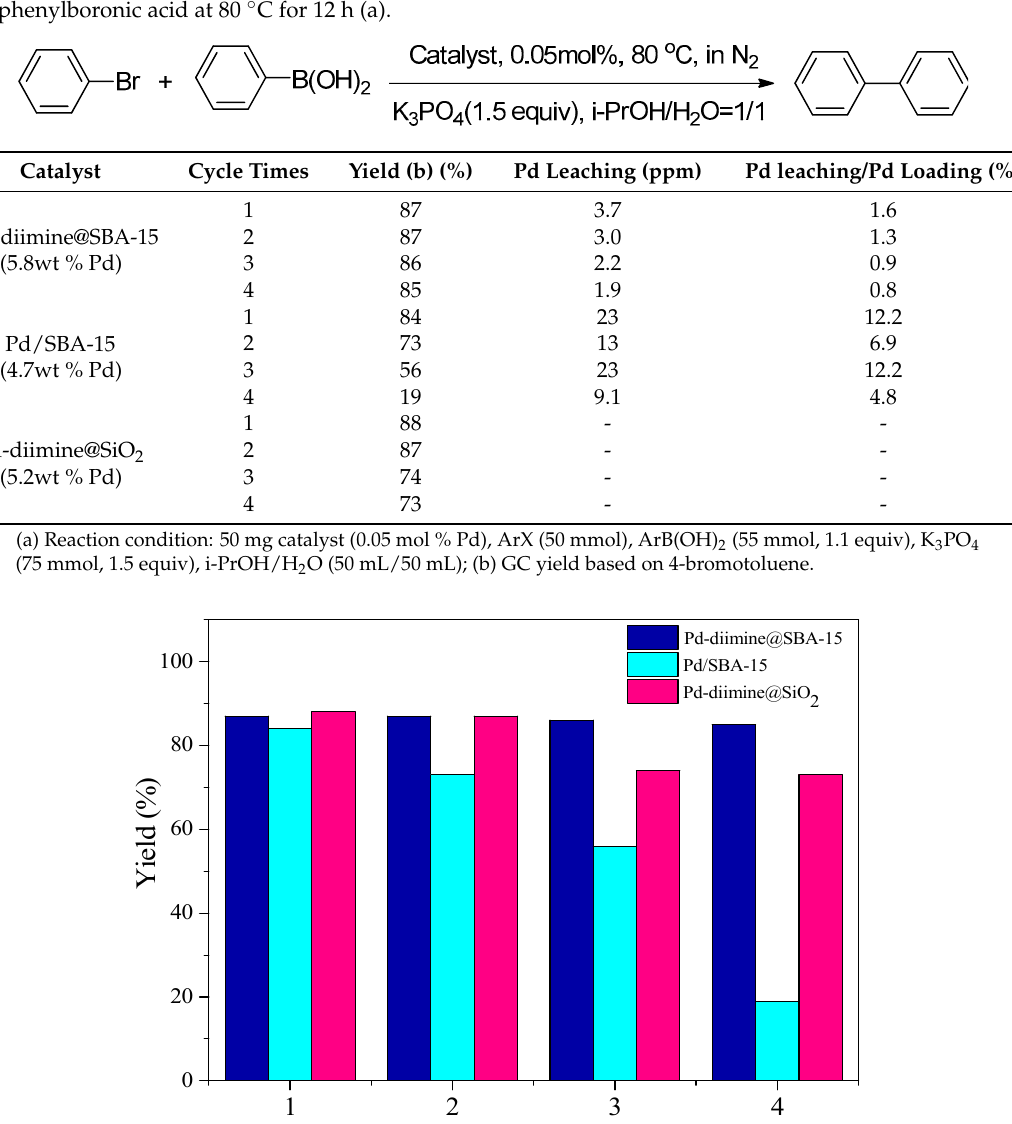
Table 4. Recyclability test of the Pd catalyst for the coupling reaction of bromobenzene and phenylboronic acid at 80 °C for 12 h (a).